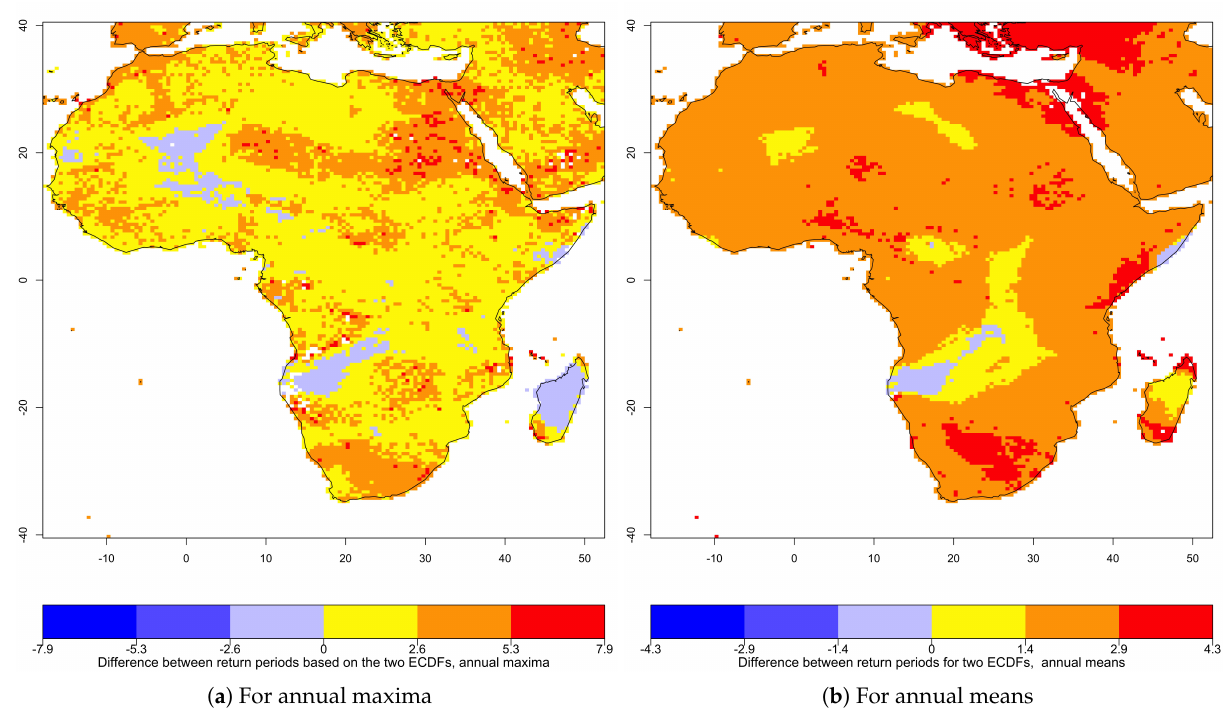
ˆ RP ECDF 2 ) for: ( a ) annual 1 − is the estimated return period based of ECDF i for i